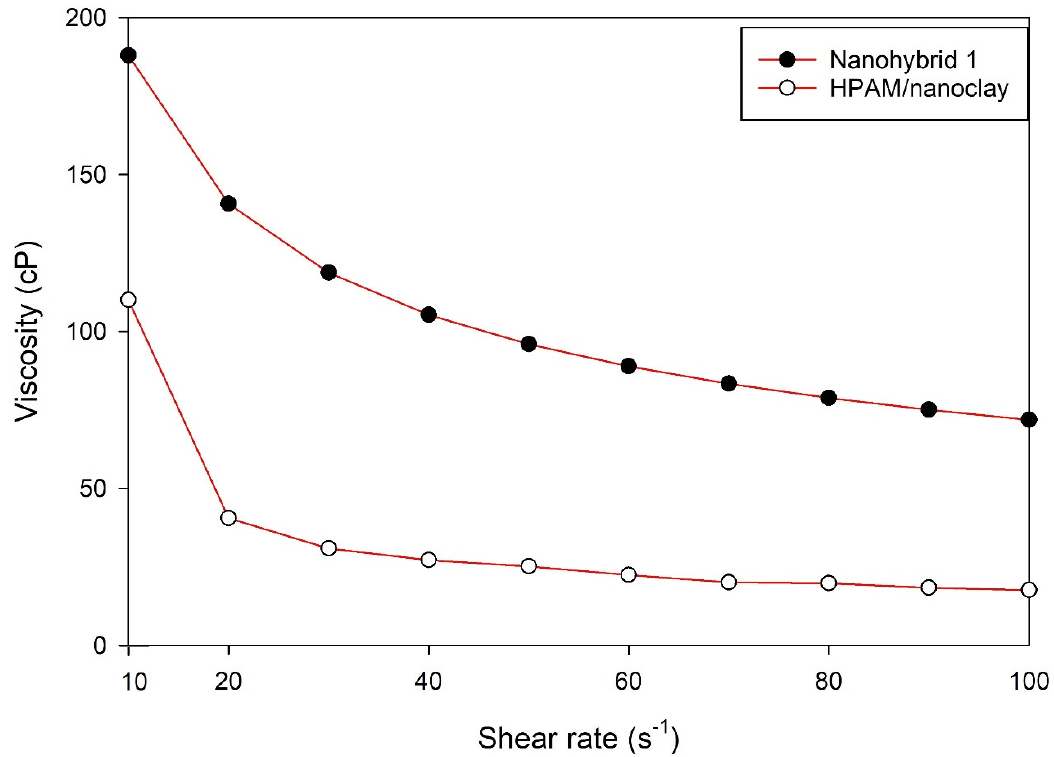
Figure 6. Comparison between the apparent viscosity of nanohybrid 1 (at 85 ◦ C) with a nanoclay-based nanohybrid composed of 0.9 g of nanoclay and 3.2 g of HPAM (at T~ 25 ◦ C) [44].